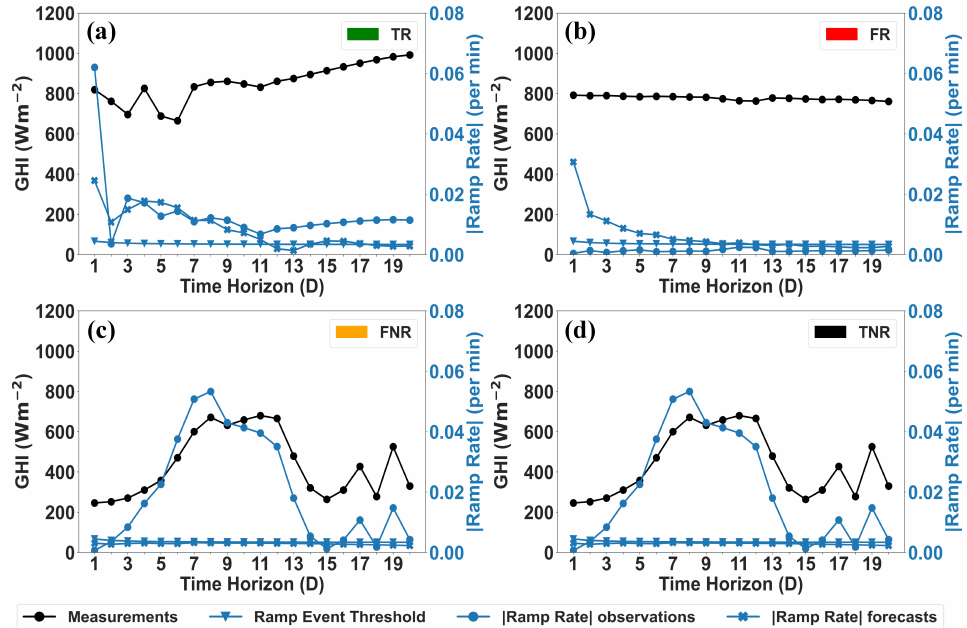
Figure 5. Example of ramp rate values within a 20 min window of ASI nowcasts for ( a ) True Ramp event (TR), ( b ) False Ramp Event (FR), ( c ) False No-Ramp Event (FNR) and ( d ) True No-Ramp Event (TNR). The black line refers to the measured GHI. The blue lines correspond to the ramp event threshold ( (cid:79) symbol) and the calculated absolute ramp rates from ASI forecasts ( × symbol) and measurements ( • symbol),